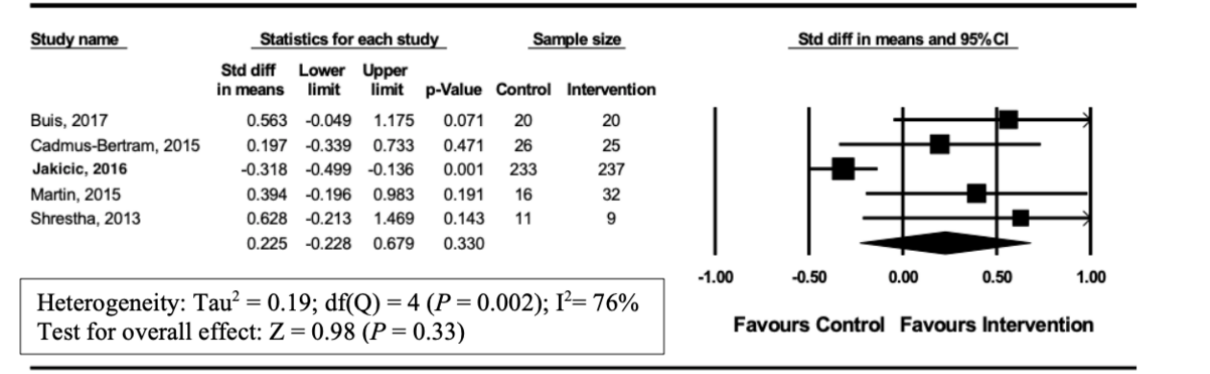
Figure 5. Forest plot of standardized mean difference (95% CI) in the effect of wearable trackers on physical activity in overweight adults.